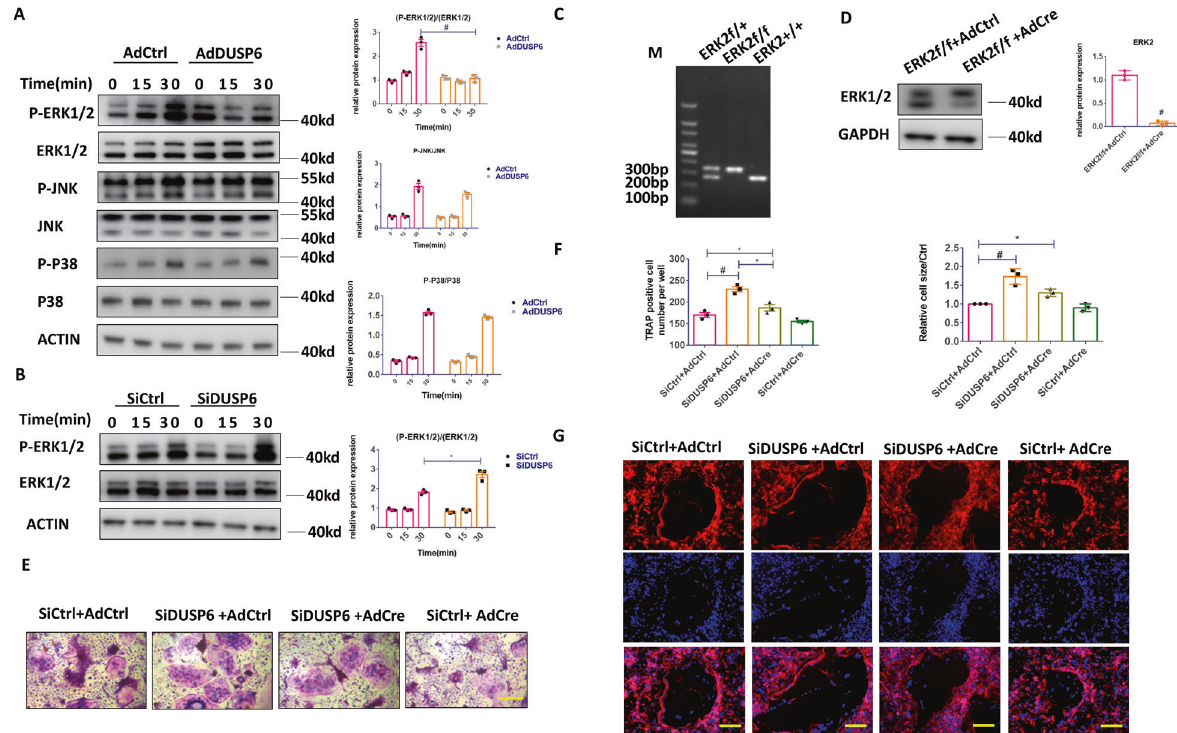
Fig. 7 DUSP6 regulated the osteoclastogenesis via ERK2 signaling. RANKL-induced osteoclast differentiation was established. A BMMs were transfected with Ad-Control (AdCtrl) and Ad-DUSP6. And phosphorylation of ERK1/2, P38, and JNK signaling pathway was analyzed for the indicated time point. B BMMs were transfected with SiControl(SiCtrl) and SiDUSP6. And the phosphorylation of ERK1/2 was examined. C The genotyping analysis was carried out using PCR to con fi rm the ERK2 deletion according to the following standard: